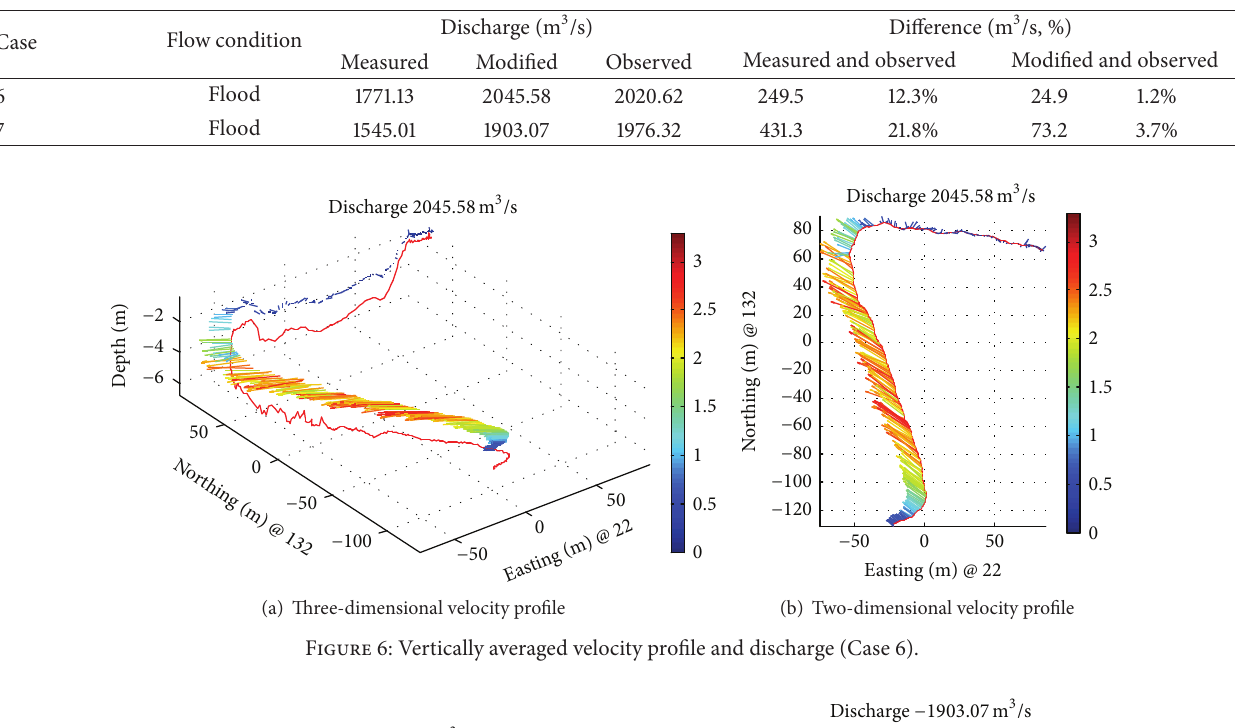
Table 7: Comparison of modified and observed discharges.